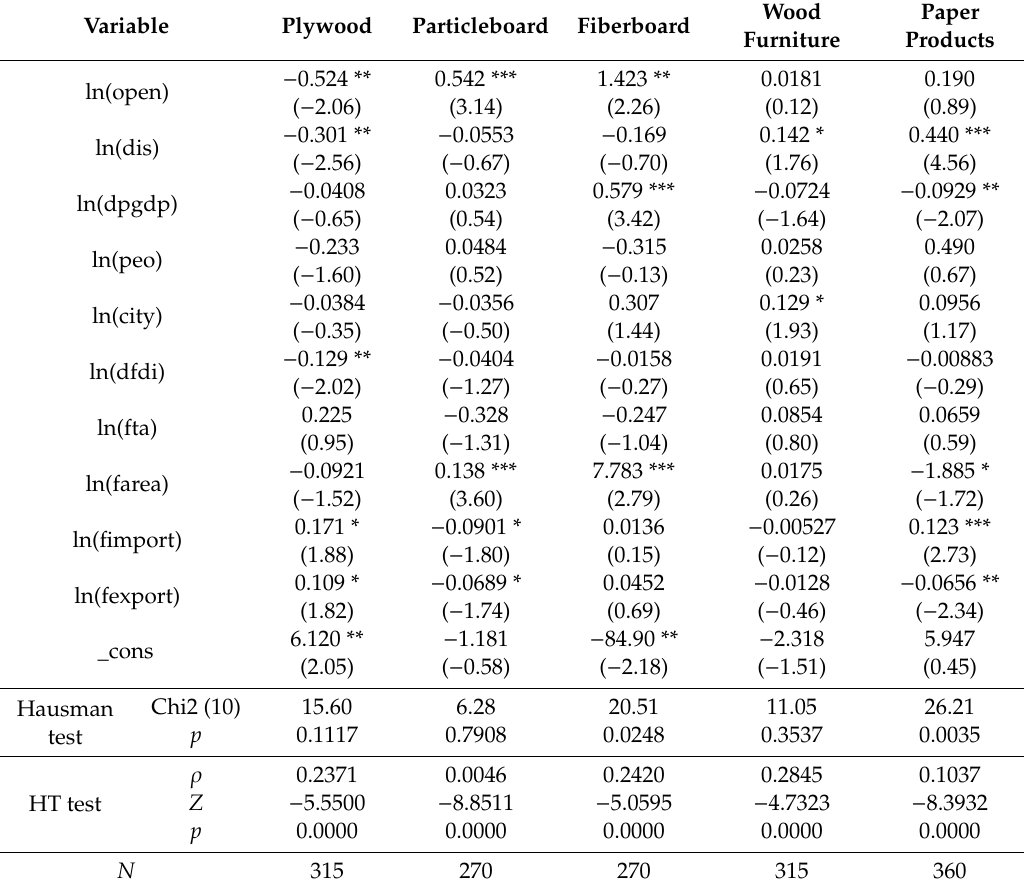
Table 6. Marginal intra-industry trade index (MIIT) regression results. Variable Plywood Particleboard Fiberboard